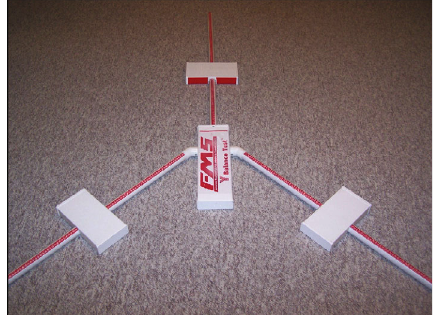
Figure 4: Y balance test kit (taken by